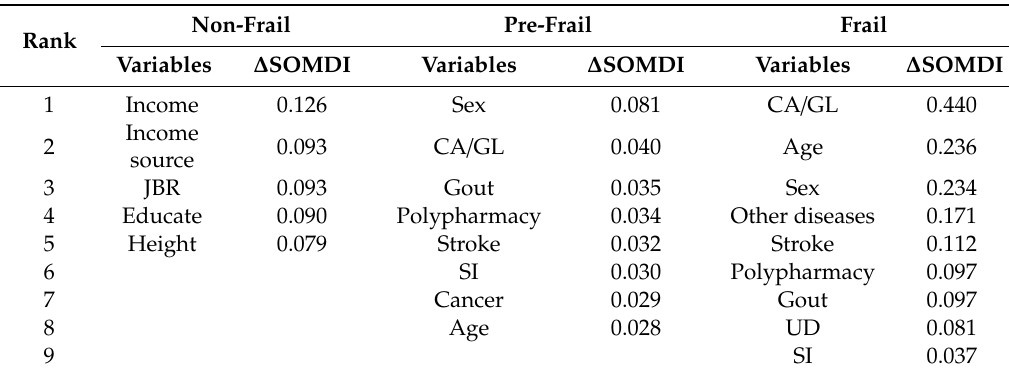
Table 2. The significant variables based on change in the self-organizing map discrimination index ( ∆ SOMDI)